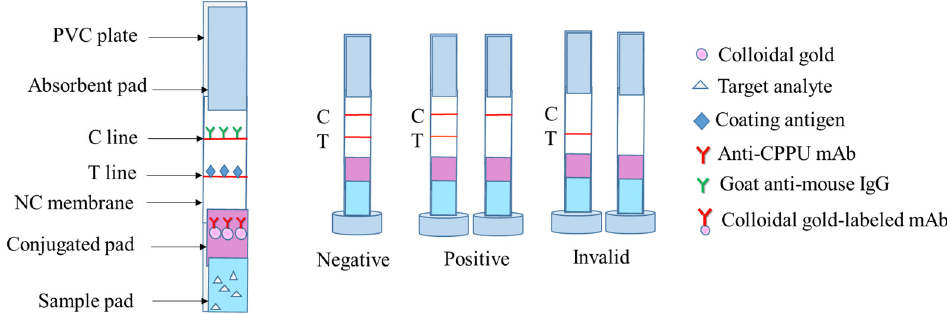
Figure 2. Schematic diagrams and the test principle of the CGN-ICTS.